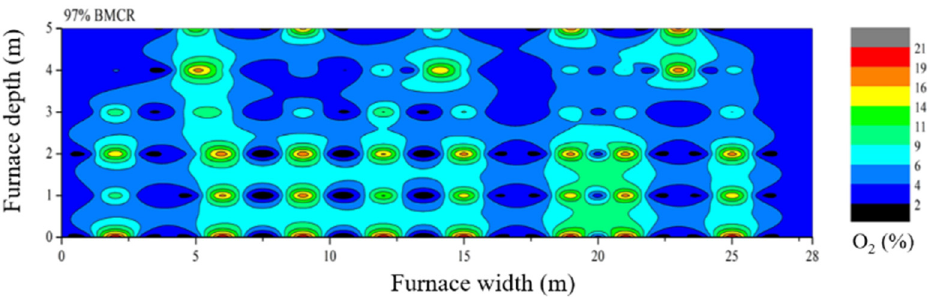
Figure 6. Oxygen distribution in the furnace section at the upper secondary air nozzle